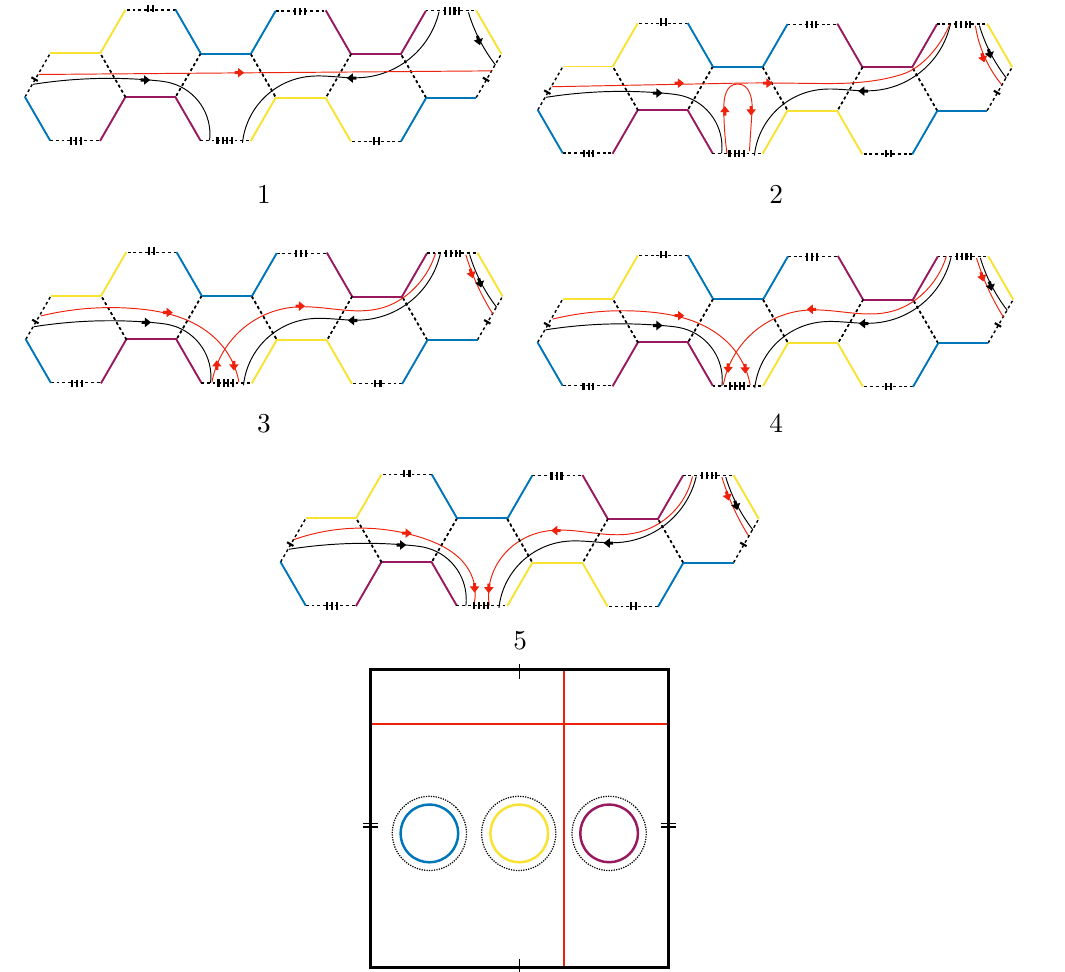
Figure 16 . 1: starting with Σ P shown in red on the copies A and A ∗ we replace Σ A with b p ( B ) ∪ b p ( C ) to get the surface in black. 2: we push the red surface up so that it touches itself. 3: at the intersection we can then reconnect the surfaces. 4: acting with the cycle between B and C we reverse the orientation of the middle segment. 5: we can then reconnect once again. The two surfaces are now equivalent. Bottom: this procedure shows that the black surface is a combination of two homology cycles. The one which Σ P belongs to and the one between B and C